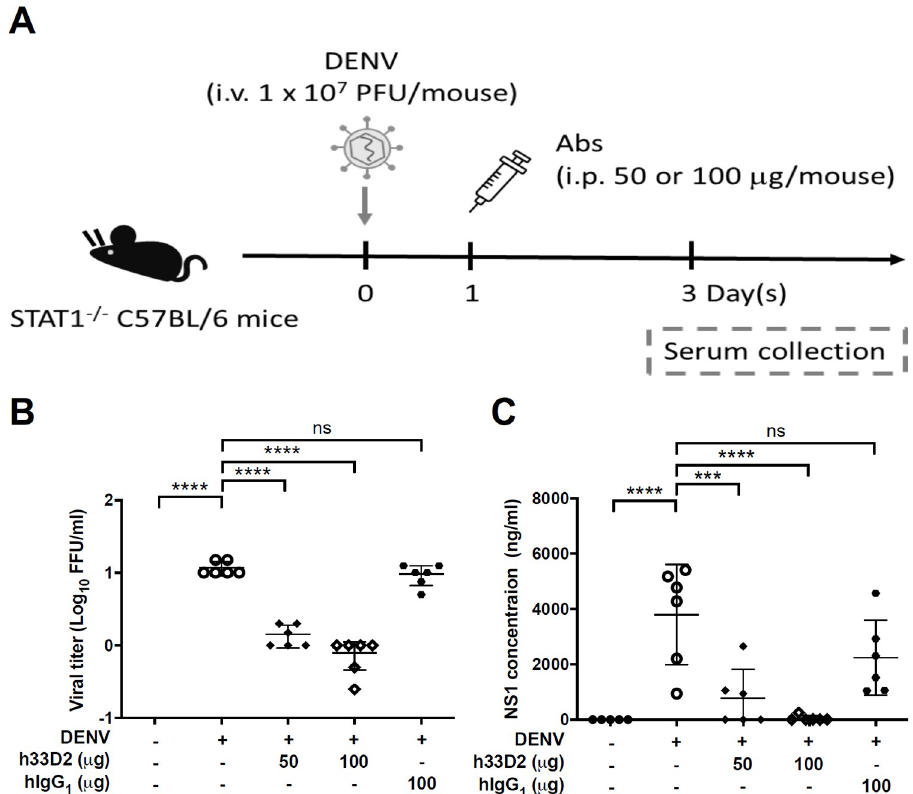
Fig 3. Passive transfer of humanized anti-NS1 mAb 33D2 into DENV-inoculated mice decreases viral titer and NS1 level in mouse sera. ( A )Schematic diagram for the therapeutic treatment of mice. The h33D2 (50 or 100 μ g/ mouse) or hIgG1 (100 μ g/mouse) were injected i.p. one day after virus challenge. 1 × 10 7 PFU/mouse DENV2-454009A or C6/36 control medium were inoculated i.v. into STAT1 -/- mice. ( B ) Viremia at 3 d.p.i. was analyzed by fluorescent focus assay. ( C )Mouse sera were collected at 3 d.p.i., and the secreted NS1 levels were analyzed by NS1 quantitative ELISA. (n = 5 for mock and n = 6 for other groups) ��� : p < 0.001, ���� : p < 0.0001, ns indicates not significant as compared with DENV alone group and based on one-way ANOVA followed by Dunnett’s multiple comparison test.